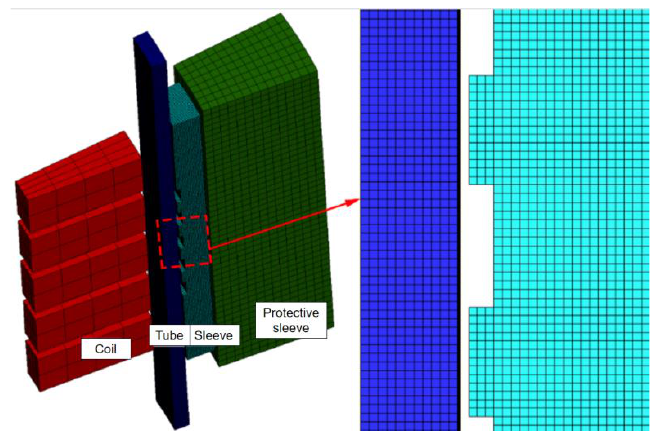
Figure 6. Finite element model of magnetic pulse forming of pipe joint.